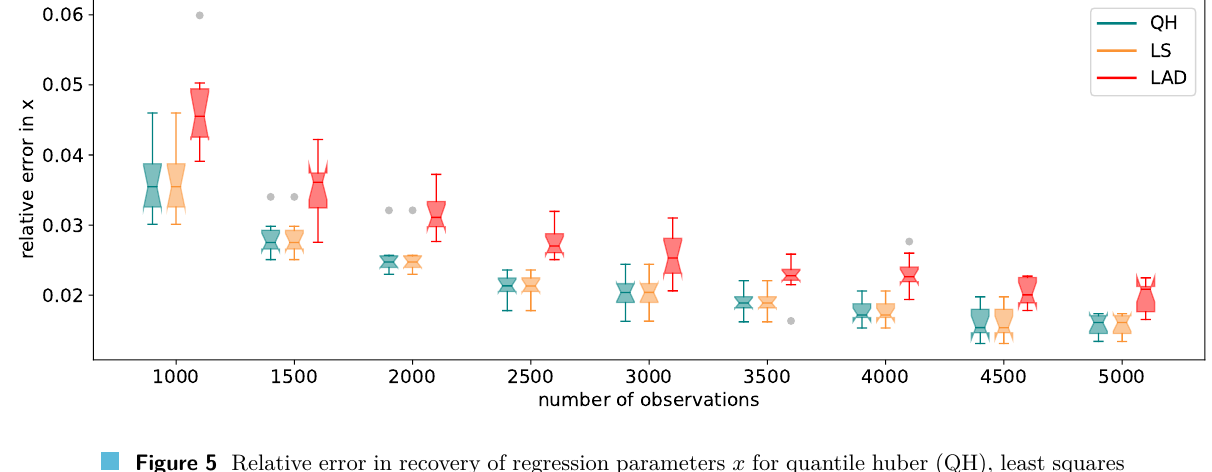
Figure 5 Relative error in recovery of regression parameters x for quantile huber (QH), least squares (LS) and least absolute deviation (LAD) approaches when generated measurement errors are N (0 , 1). Box plots summarize results across 10 realizations of each experiment. The quality of quantile Huber results is identical to that of the least squares solution, which is optimal in this nominal case. LAD solutions are comparable but always worse in terms of relative